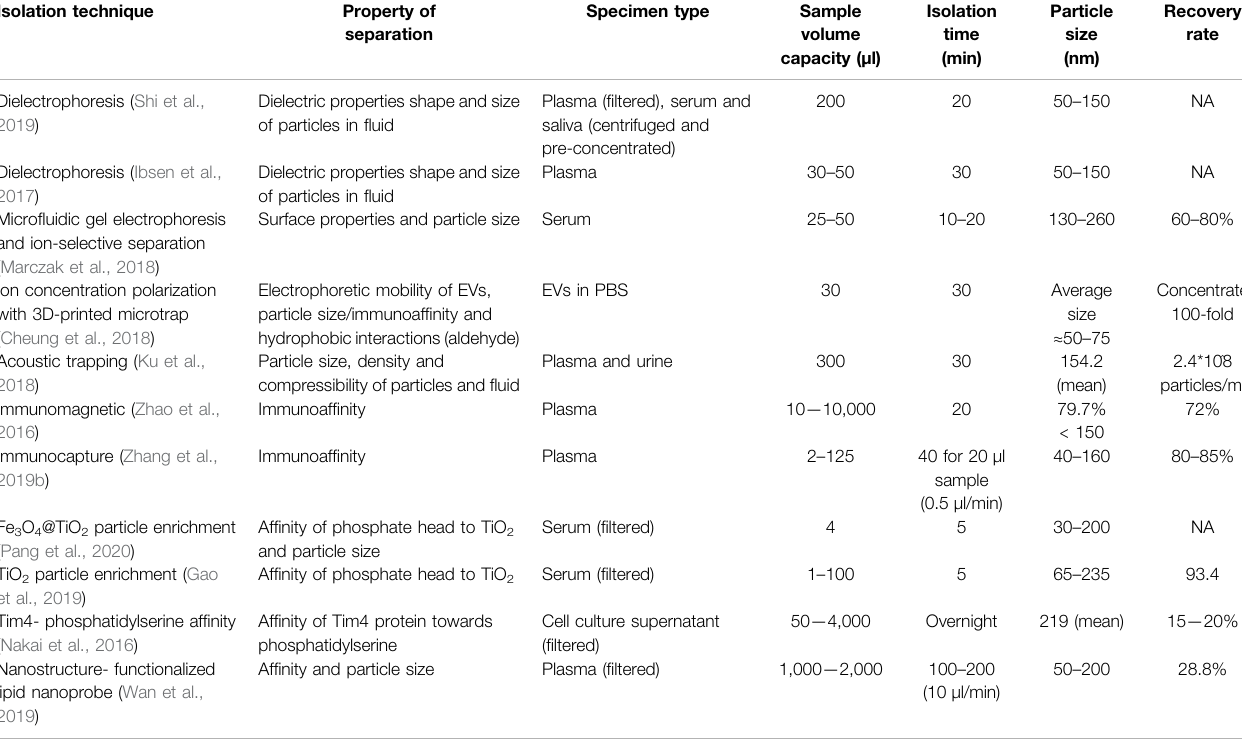
TABLE 1 | Performance characteristics of highly speci fi c exosome isolation